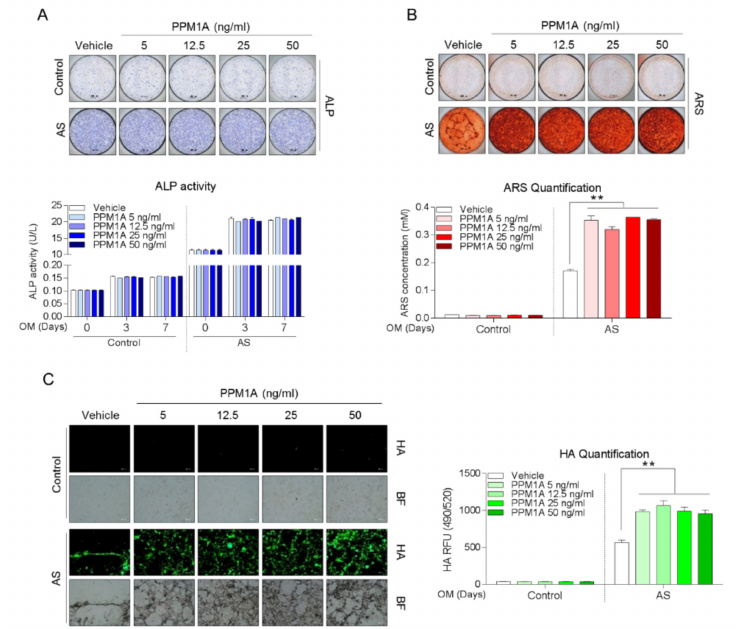
Figure 4. Both control- ( n = 4) and AS-osteoprogenitors ( n = 3) were stimulated with as indicated PPM1A dose during osteogenic di ff erentiation, and subjected to analysis for ( A ) ALP staining and activity at 0, 3, and 7 days, ( B ) ARS staining and quantification at 21 days, and ( C ) Hydroxyapatite staining and quantification at 21 days. Data are presented as means + SD; ** p < 0.01 by unpaired